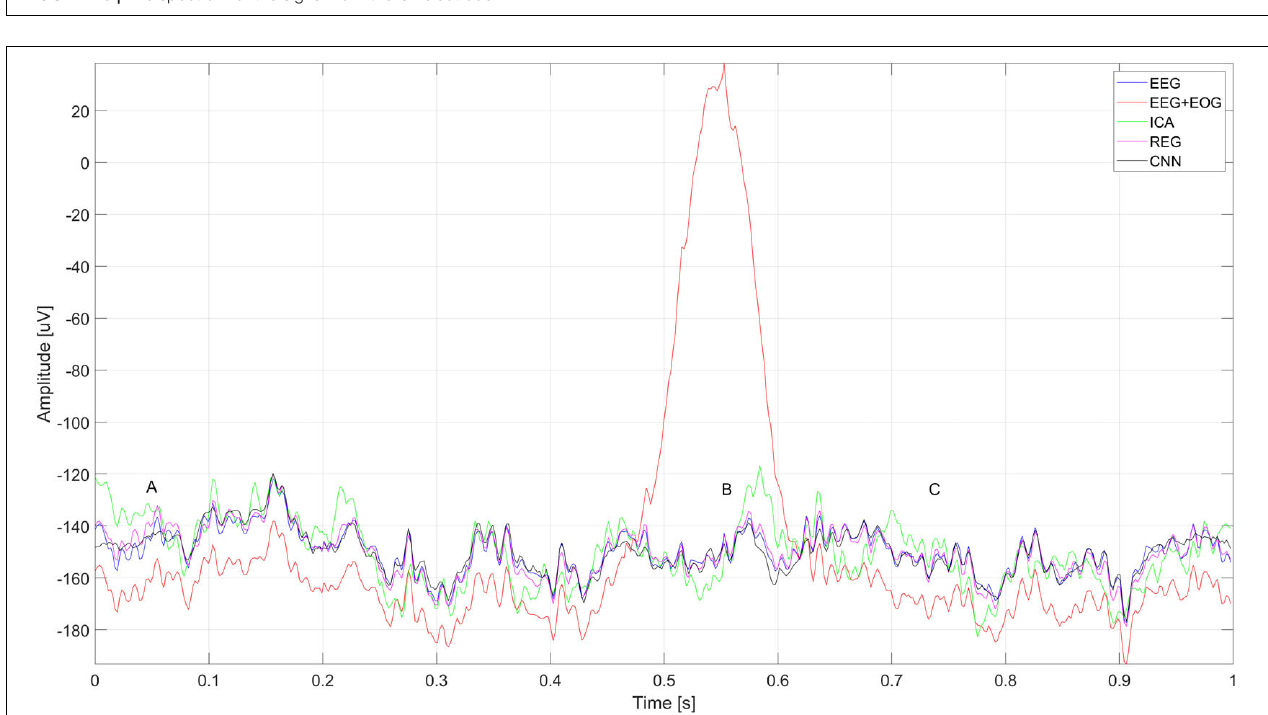
FIGURE 17 | A fragment of the simulated EEG signal for the Cz electrode. The letters A–C represent selected moments: A and C the EEG signal fragment without artifacts and B with an eye blink